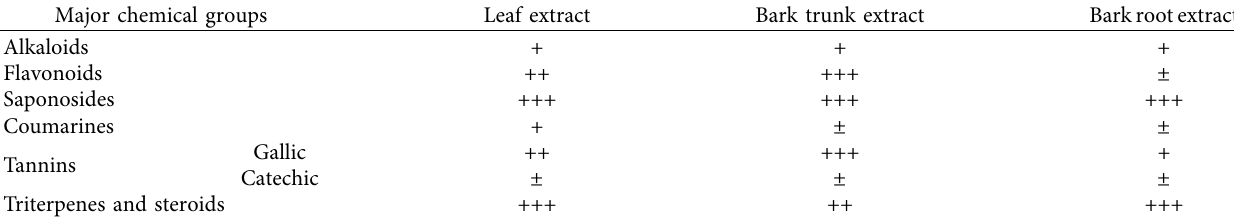
Table 1: Phytochemical components of P. santalinoides .